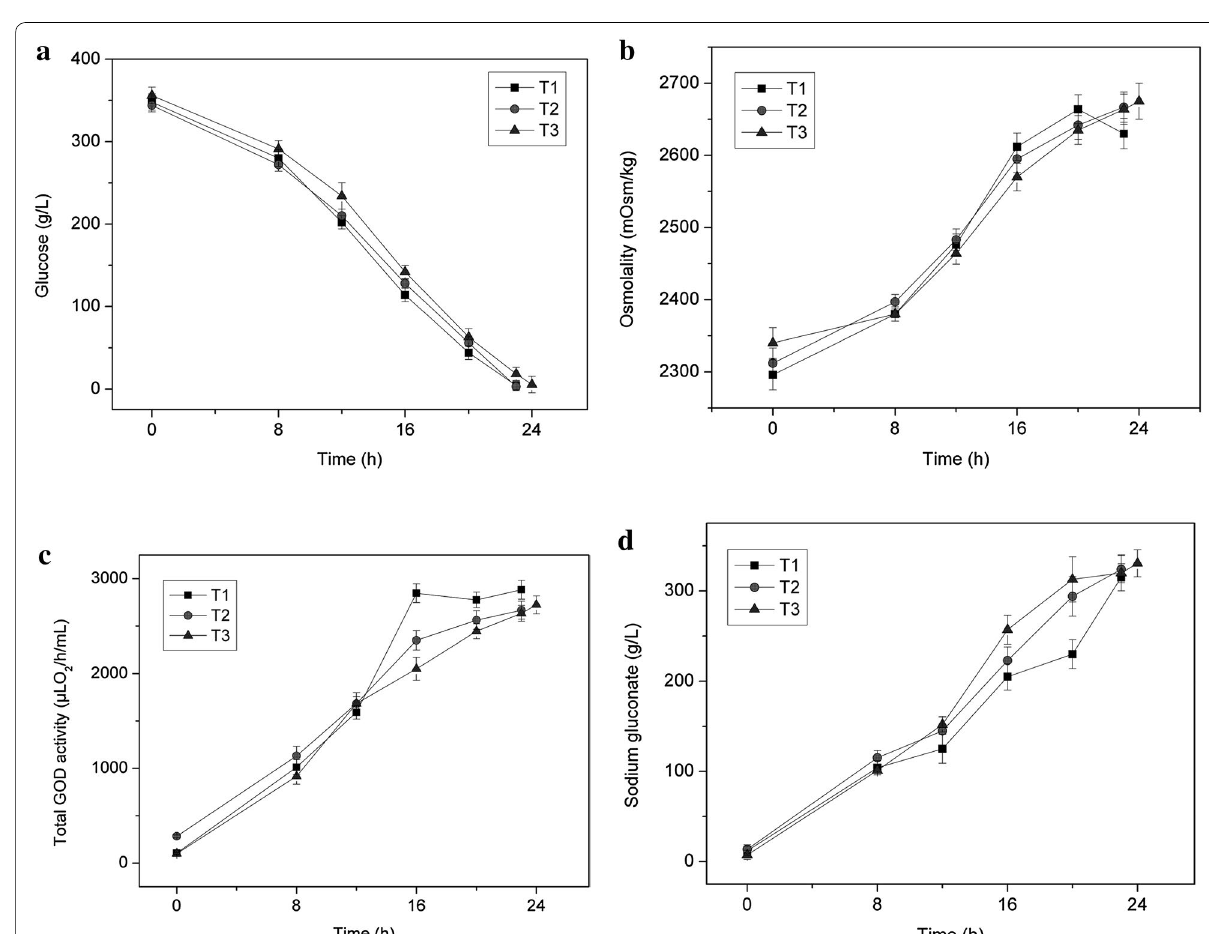
Fig. 12 Effects of different seed cultures with same initial osmolality on sodium gluconate fermentation by A. niger . a Glucose consumption, b environmental osmotic pressure, c total GOD activity, and d sodium gluconate